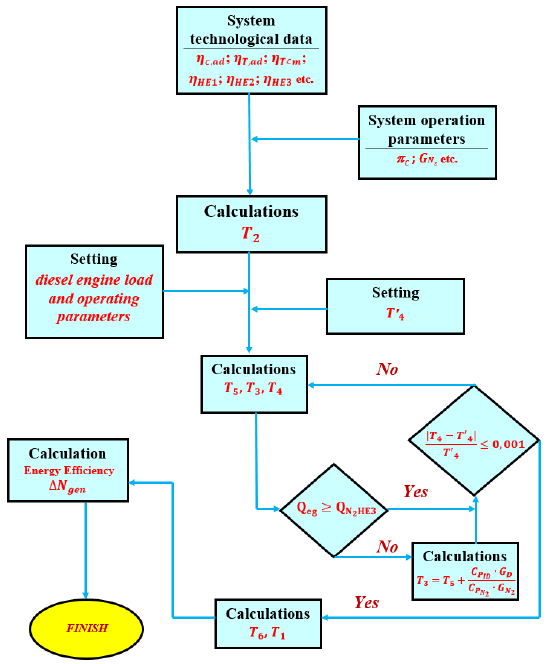
Figure 2. Algorithm for the simulation of the LNG ship’s power plant cogeneration cycle.